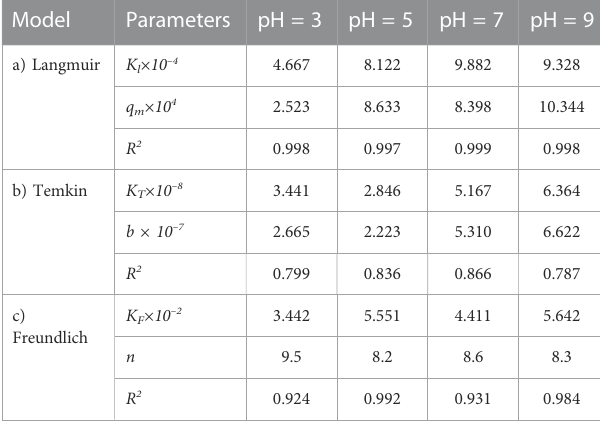
The italic values are parameters of the